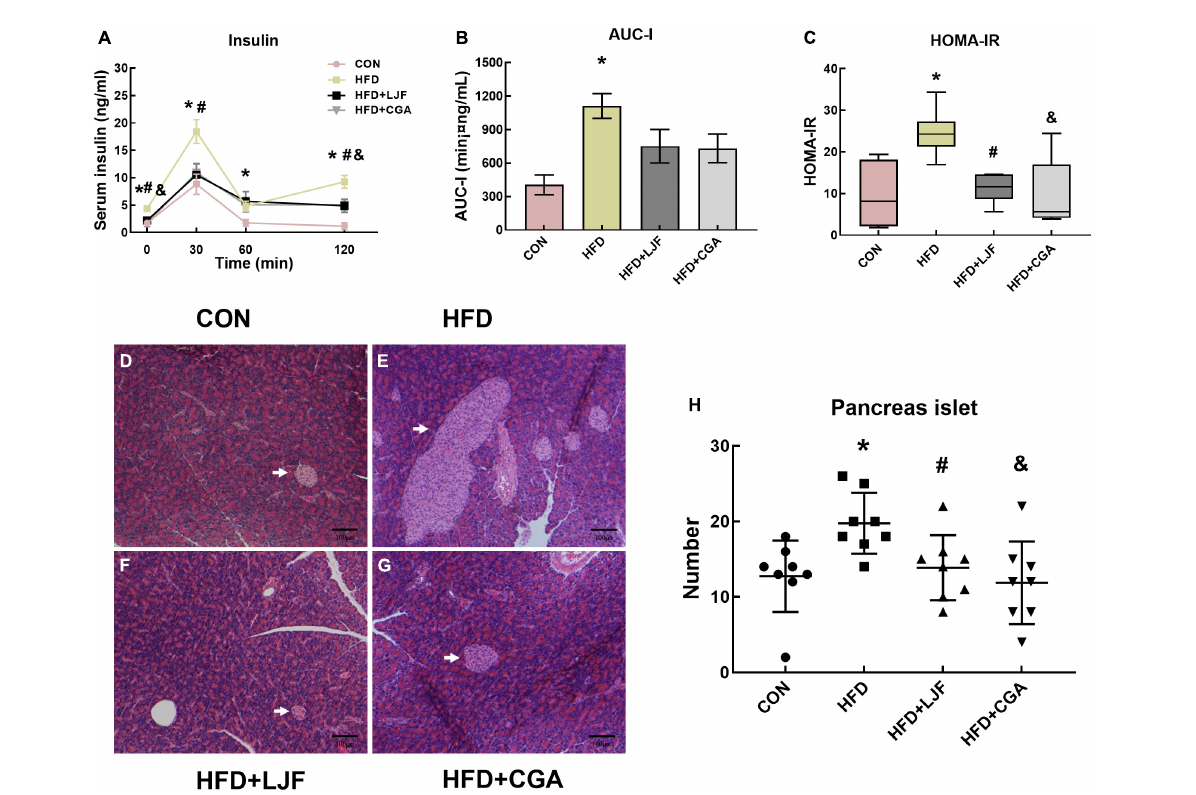
FIGURE3 Lonicerae Japonicae Flos and CGA protect against HFD-induced IR and glucose homeostasis disorder and significantly reduce islet hyperplasia in prediabetes rats. (A) Serum insulin levels during the last OGTT timepoint ( n = 6 per group). (B) The area under the curve of serum insulin (AUC-I) ( n = 6 per group). (C) Homeostasis model assessment of insulin resistance (HOMA-IR) presented as box and whiskers plots, minimum to maximum, where the center line represents the median ( n = 6 per group). (D–G) Representative H&E stained images of the pancreas (Scale bar represents 100 µ m; x100) in the indicated group; islets (white arrows). (H) Scatter plot graphs (bottom panels) represent the number of pancreatic islets, each dot represents one rat. Other data are presented as bar graphs with means ± SEM. * P < 0.05, HFD group vs. CON group;